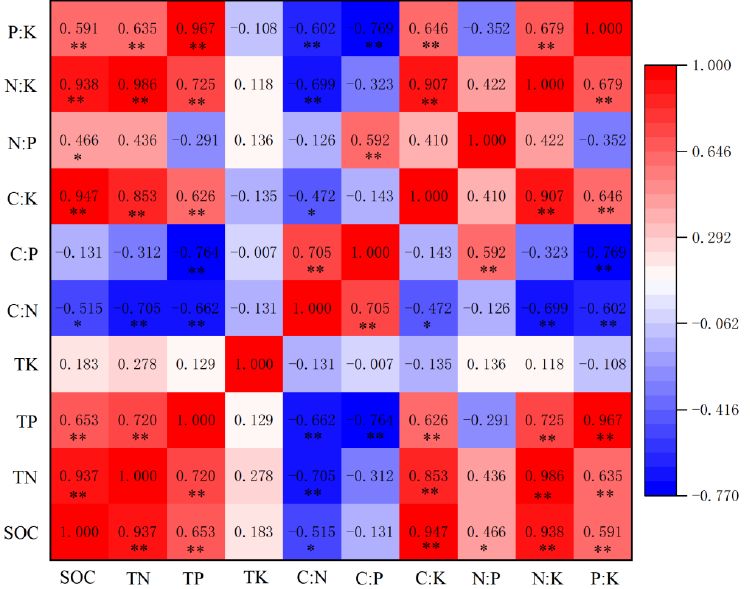
Figure 6. Pearson’s correlation heatmap of bulk soil nutrient concentrations and pH: * Significant at p < 0.05; ** significant at p < 0.01.